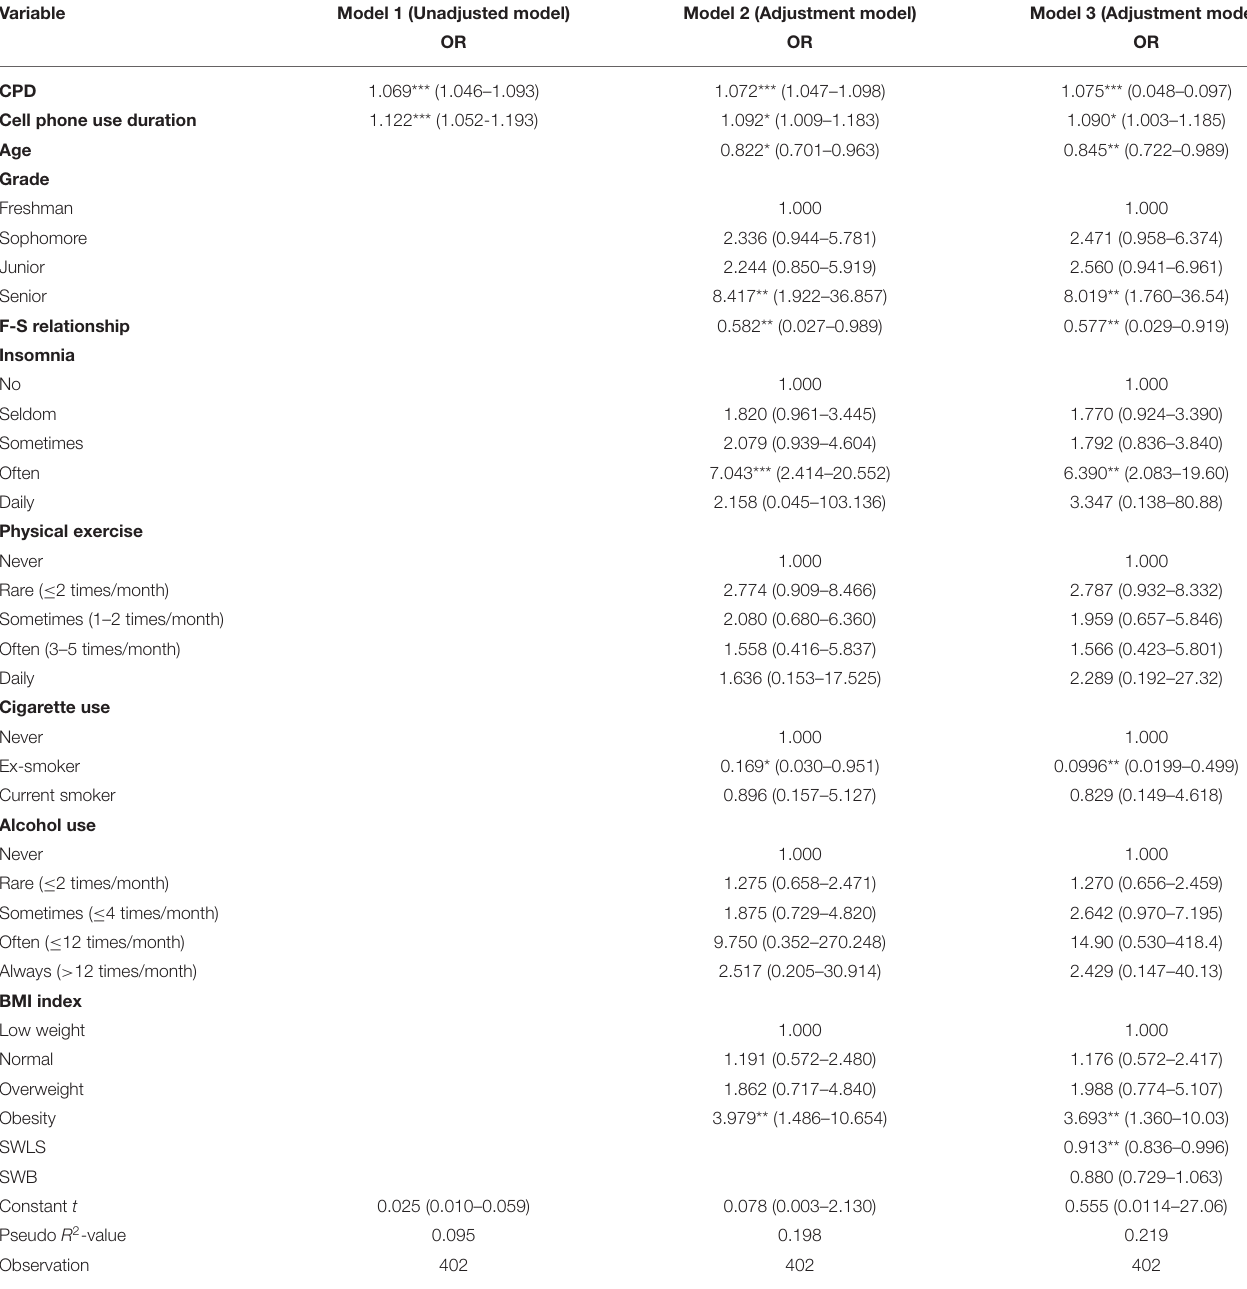
TABLE 3 | Logistic regression analysis results ( N =